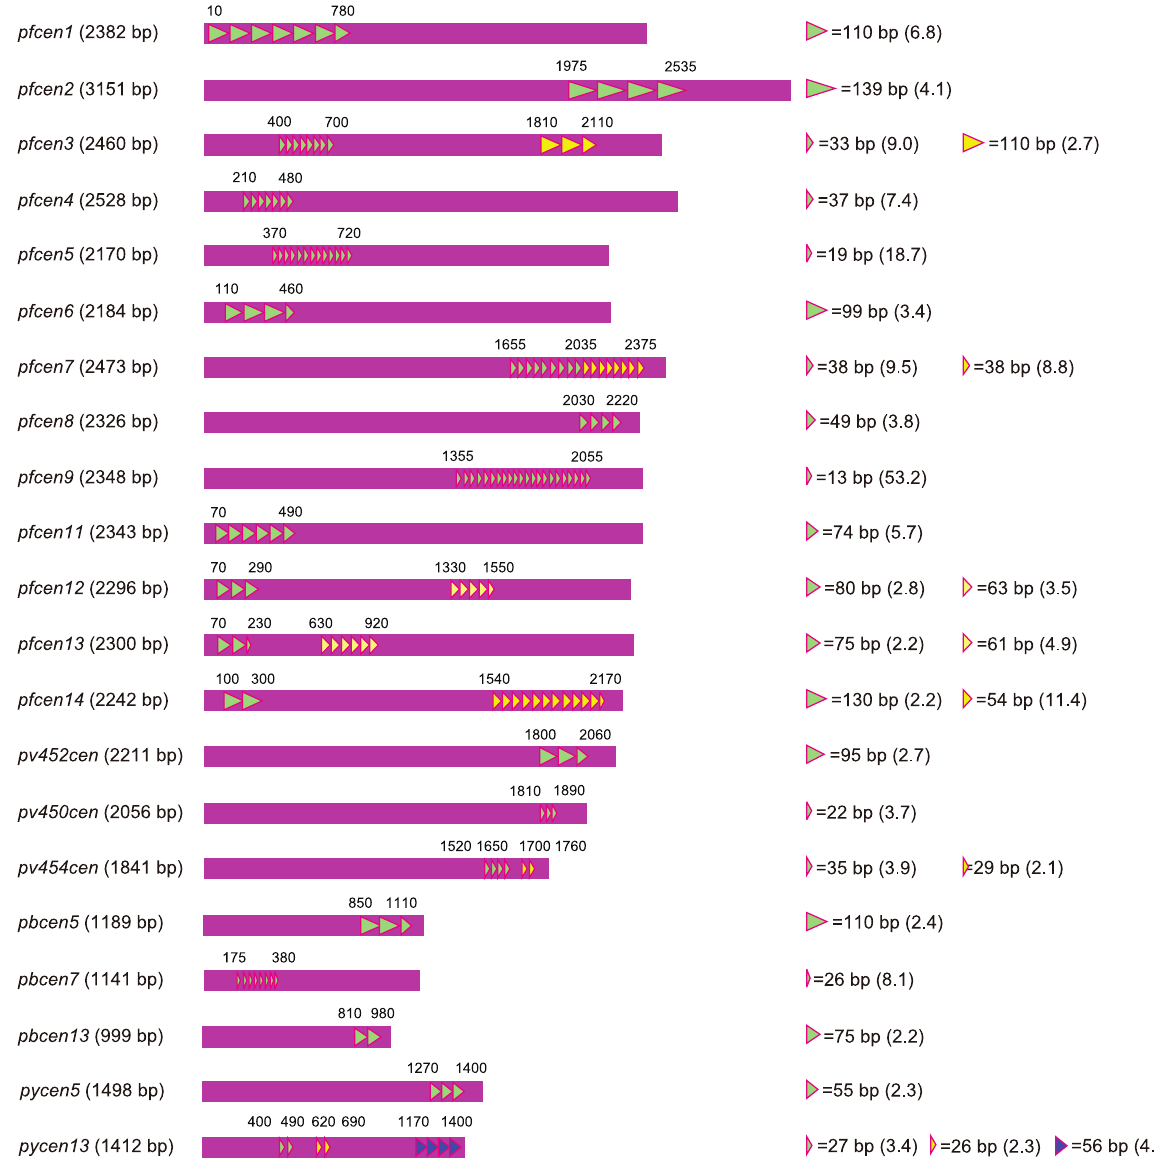
Figure 1. Centromere of Plasmodium spp. Schematic drawings of the centromeres of Plasmodium spp., including P. falciparum , P. vivax , P. berghei , and P. yoelii are shown. Each centromere of P. falciparum , P. berghei and P. yoelii is named after the corresponding chromosome number, and the centromeres of P. vivax are named after the corresponding contig numbers. Triangles indicate the repetitive sequence elements that were identified using the Tandem Repeats Finder program. The numbers in parenthesis show the repeat counts for each repetitive region. Other sequence information is summarised in Table S1.